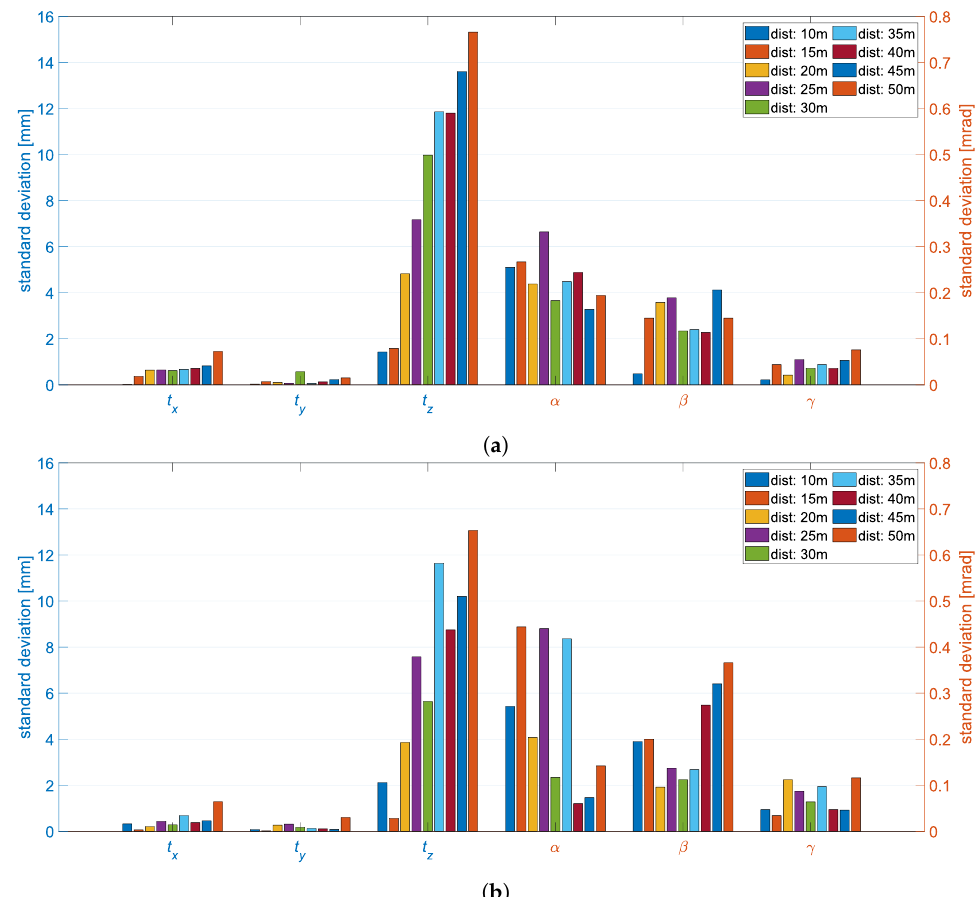
Figure 15. Standard deviations of the object pose from the test measurements at distances varying from 10m to 50m. Differentiated by object orientation into orthogonal ( a ) and oblique ( b ) according to the optical axis of the stereo camera